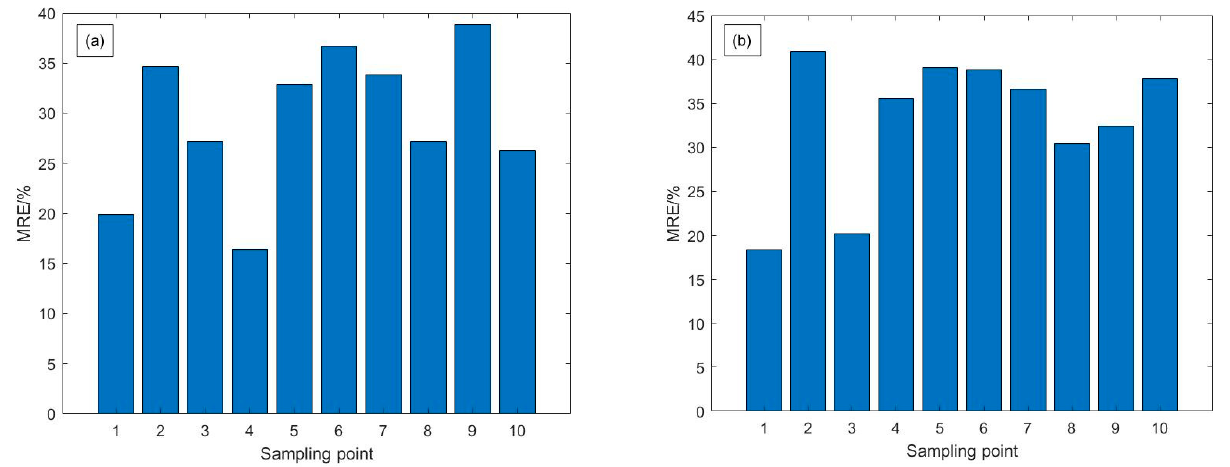
Figure 10. The relative error diagram of the inversion value and the measured value of the sampling point: ( a ) Chlorophyll a; ( b ) SPM.